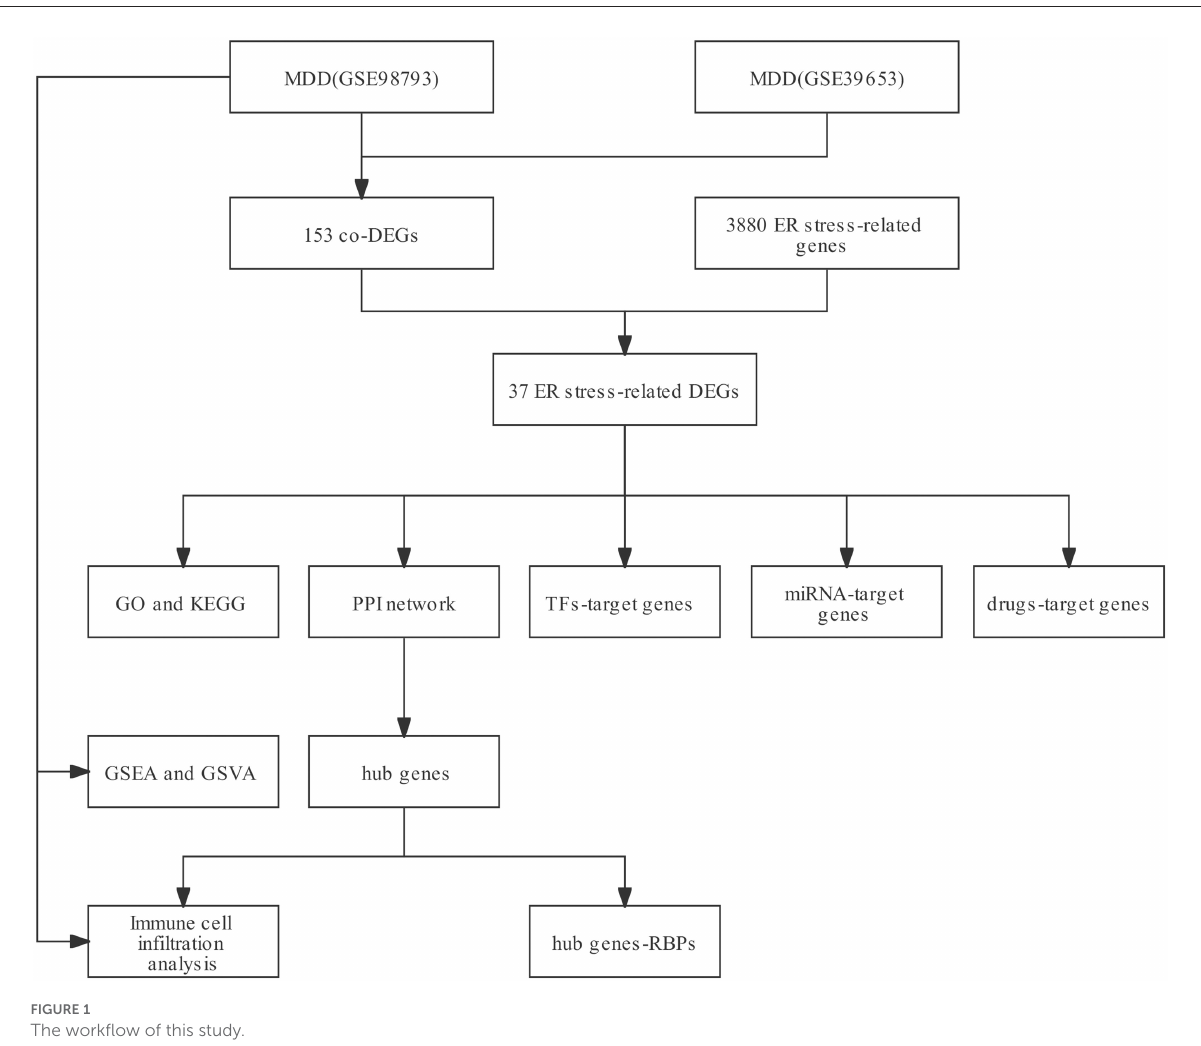
FIGURE1 The workflow of this